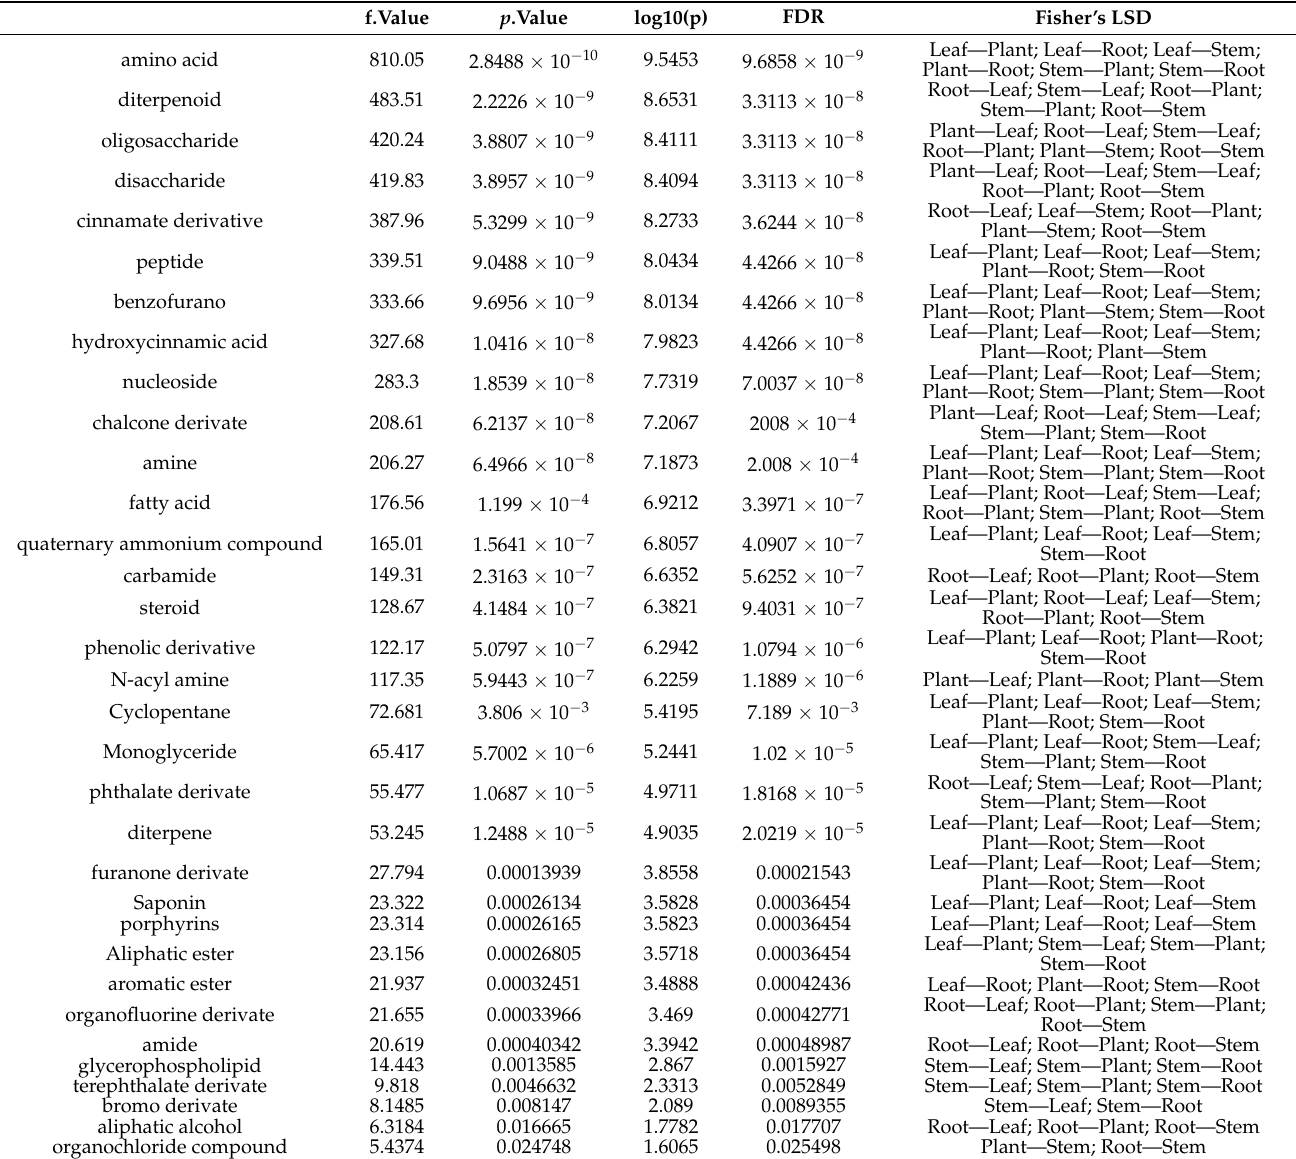
Table 2. Ontology based-metabolomics of B. pilosa plant